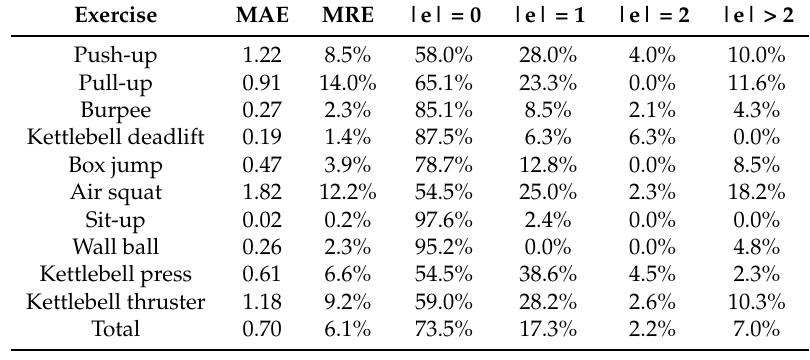
Table 7. Repetition counting performance for the constrained setting. For each exercise, we indicate the mean absolute error (MAE), mean relative error (MRE), and error distribution.